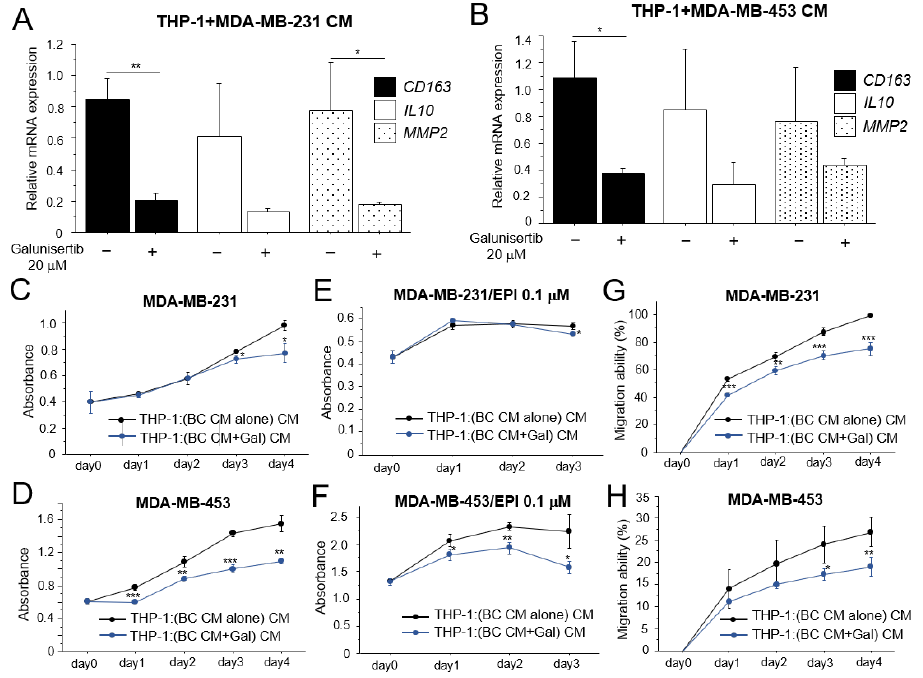
Figure 4. Increased pro-tumorigenic activity of macrophages by transforming growth factor (TGF)- β from breast cancer cells. ( A , B ): Expression of CD163 , IL10 , and MMP 2 mRNA in THP-1-derived macrophages treated with CM from MDA-MB-231 ( A ) and MDA-MB-453 ( B ) cells along with Galunisertib (20 μM) (72 h). The data are presented as the mean ± S.D. ( n = 3). ( C – H ): Cell proliferation ( C , D ), chemoresistance to EPI ( E , F ) and migration ( G , H ) assays in MDA-MB-231 ( C , E , G ) and MDA-MB-453 ( D , F , H ) cells using the CM of THP-1-derived macrophages treated with CM from